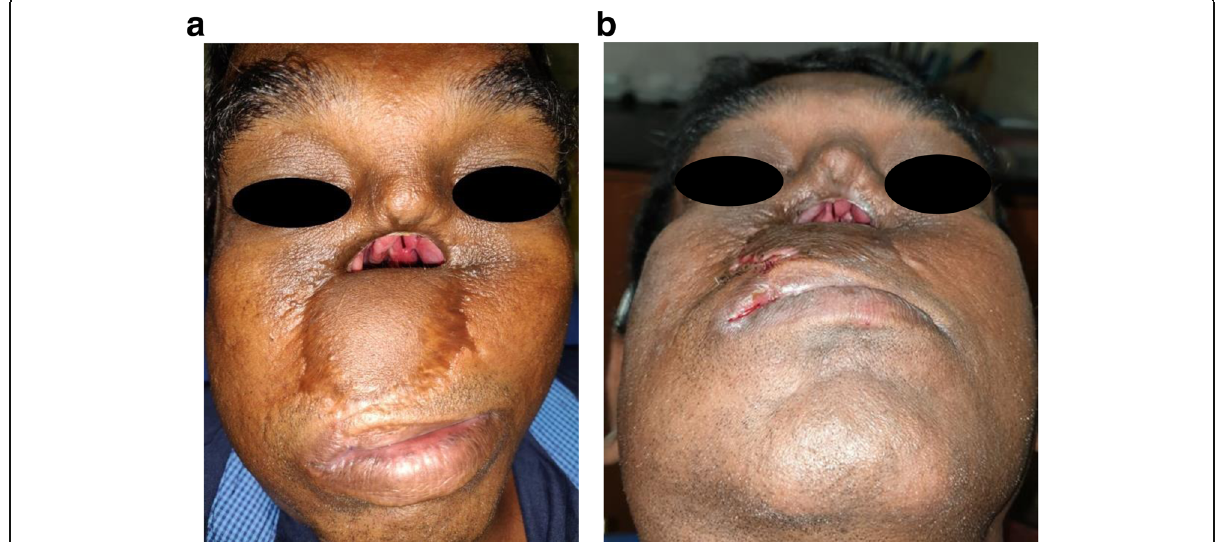
Fig. 2 a , b Pre-operative facial view — a broad nasal opening is visible, which led to anterior facial